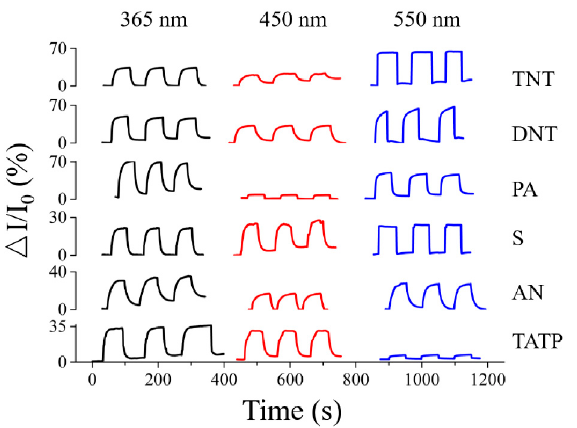
Figure6. ResponseofTiO 2 / Aphentodi ff erentexplosivesunder365nm, Figure 6. Response of TiO 2 /Aphen to different explosives under 365 nm, 450 nm and 550 nm illumination.